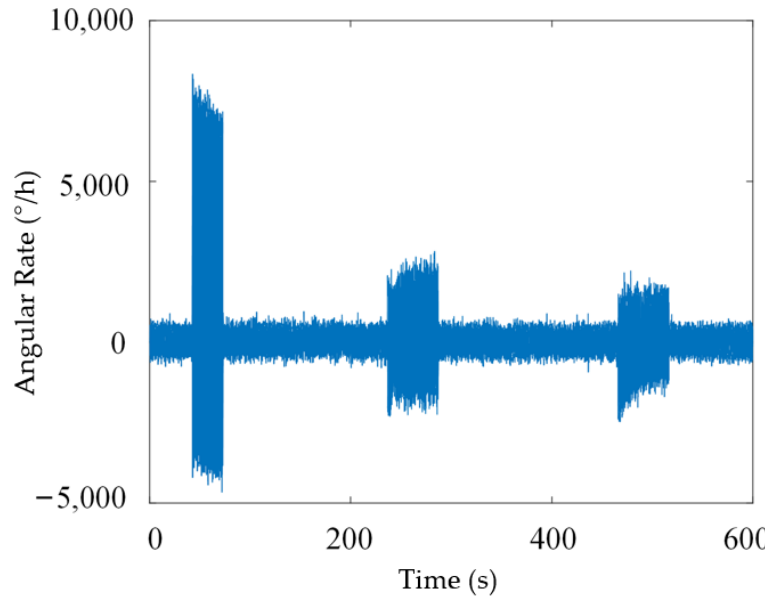
Figure 4. MEMS gyroscope original output signal.